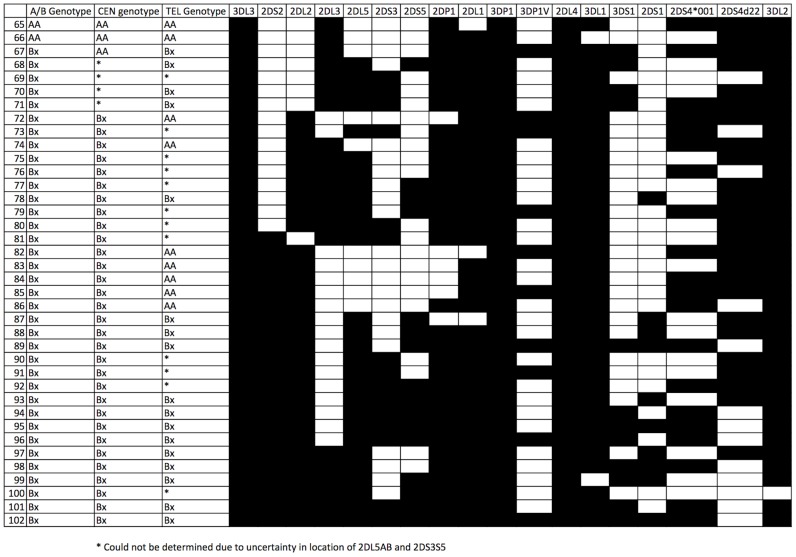
KIR genotypes and that were uniquely identified in the F1 population.